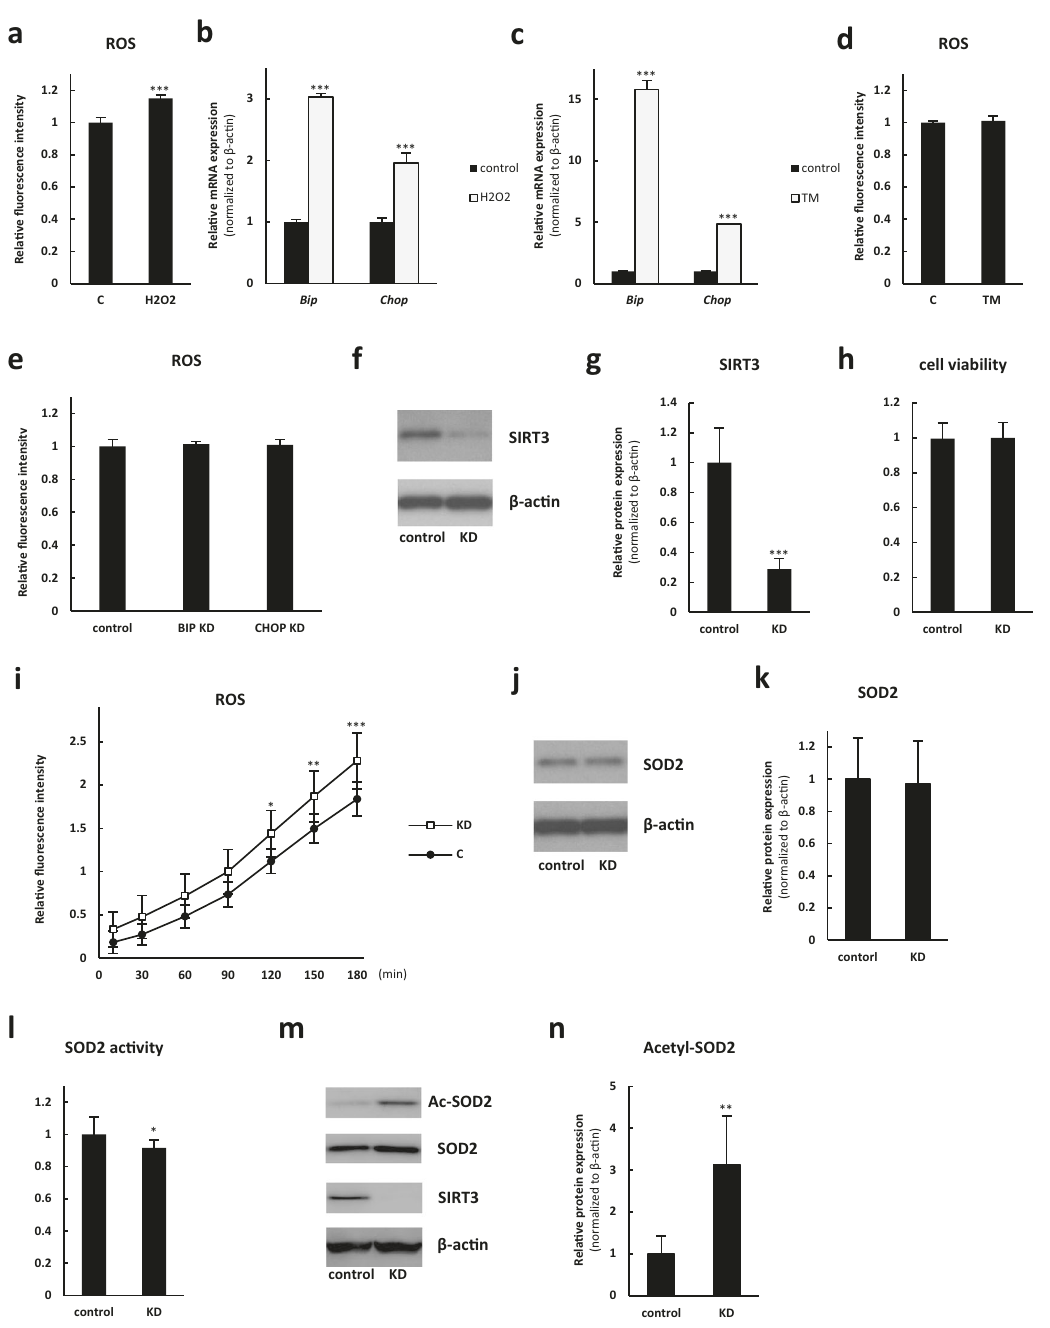
Fig. 6 SIRT3 knockdown 661 W cells showed elevated reactive oxygen species (ROS) levels and decreased superoxide dismutase 2 (SOD2) activity. a in vitro ROS measurement 2 h after H 2 O 2 treatment ( n = 5 for each group). b Relative mRNA expression of Bip and Chop 2 h after H 2 O 2 treatment ( n = 5 for each group). c Relative mRNA expression of Bip and Chop 3 h after tunicamysin (TM) treatment ( n = 5 for each group). d in vitro ROS measurement 3 h after TM treatment. ( n = 5 for each group). *** p < 0.001 by two-tailed unpaired t -test. e in vitro ROS measurement after transfection with control siRNA, Bip siRNA (BIP KD), and Chop siRNA (CHOP KD) ( n = 6 for each group). No signi fi cant difference by one-way ANOVA with post hoc Tukey ’ s HSD test. f , g Immunoblot against SIRT3 of 661 W cells with negative control shRNA (control) and SIRT3 knockdown (KD) ( n = 6 for each group). *** p < 0.001 by two-tailed unpaired t -test. h Cell viability assay of 661 W cells transfected with control and SIRT3 KD ( n = 5 for each group). i ROS assay of control and SIRT3 KD 661 W cells ( n = 10 for each group). * p < 0.05, ** p < 0.01, and *** p < 0.001 by two-way ANOVA with post hoc Bonferroni ’ s multiple comparisons test. j , k Immunoblot against SOD2 of control and SIRT3 KD 661 W cells ( n = 5 for each group). l SOD2 activity assay of control and SIRT3 KD 661 W cells ( n = 12 for each group). * p < 0.05 by two-tailed unpaired t -test. m , n Immunoblot against acetylated SOD2 (Ac-SOD2) of control and SIRT3 KD 661 W cells ( n = 5 for each group). ** p < 0.01 by two-tailed unpaired t -test. Values are mean ±